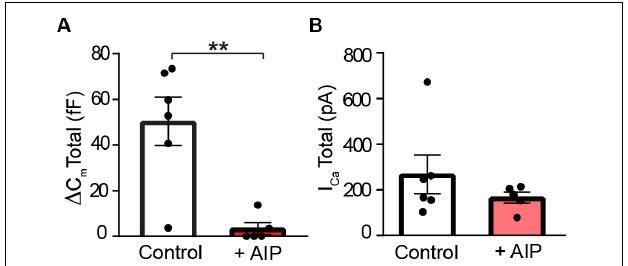
FIGURE 8 | CaMKII inhibition suppresses exocytosis at rod bipolar cell terminals. (A) Total exocytosis, measured after ten depolarizing stimuli ( − 65 to − 20 mV, 100 ms duration, 4 Hz; Wan et al., 2010), was significantly smaller when AIP (25 µ M) was included in the internal recording solution than under control conditions ( p = 0.0059). (B) The mean total I Ca , summed over the pulse train, was not significantly different in the absence or presence of AIP ( p = 0.2948). For A, B , control: n = 6 cells/4 mice; AIP: n = 5 cells/3